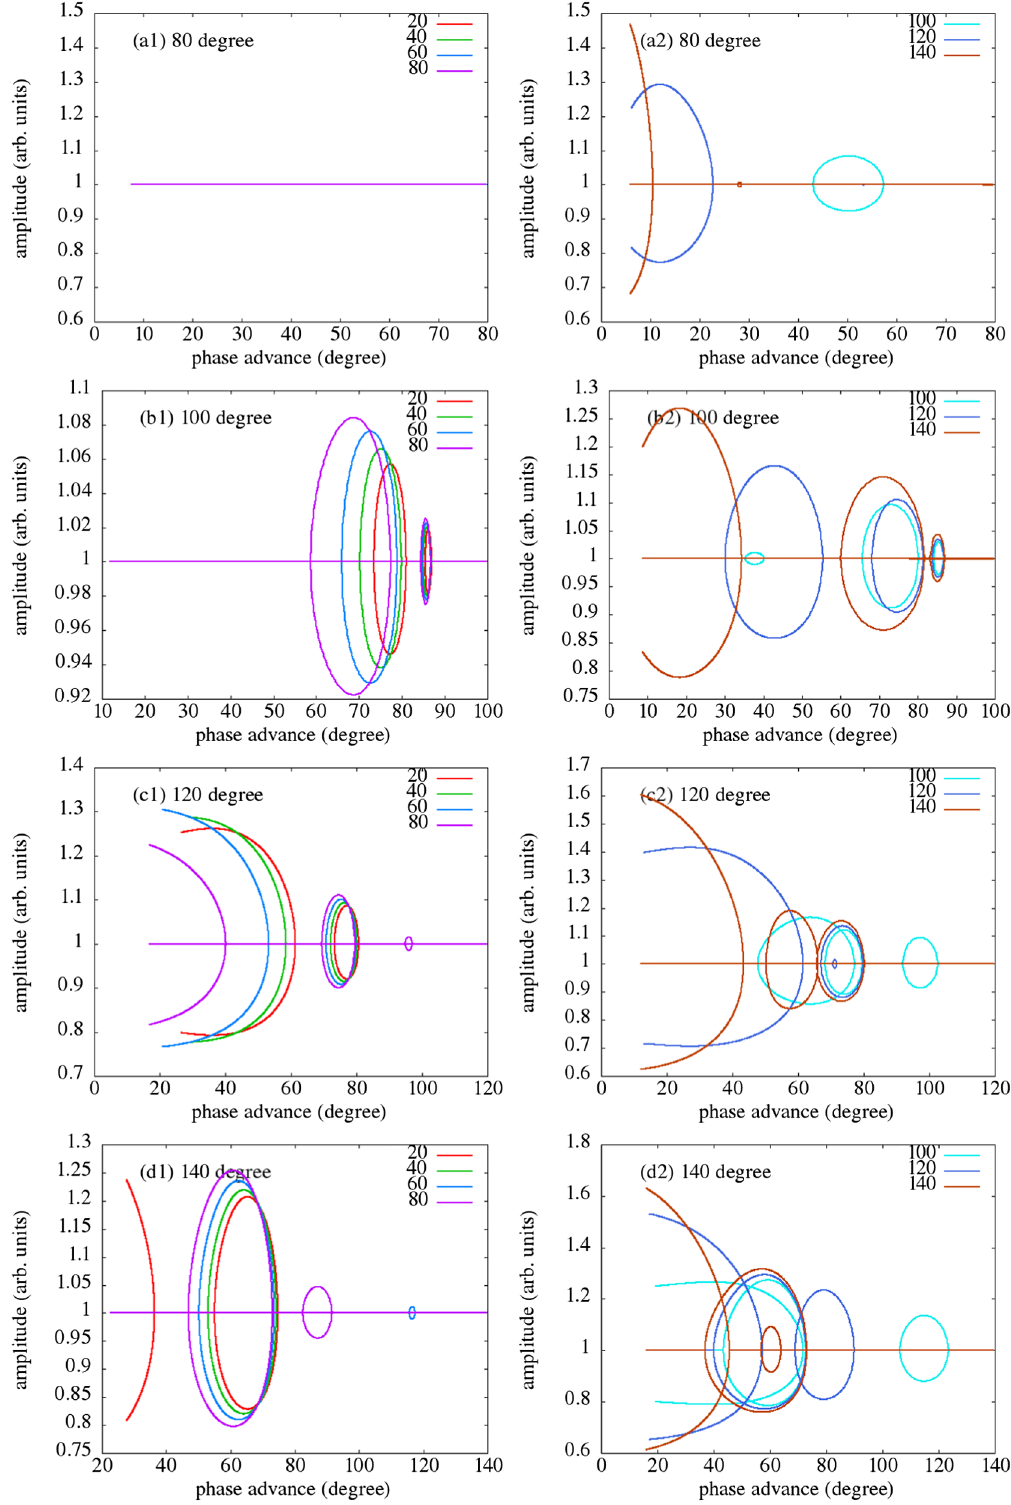
FIG. 2. The 3D envelope mode growth rate amplitudes as a function of depressed transverse phase advance with 20 °, 40 °, 60 °, 80 °, 100 °, 120 °, and 140 ° zero current longitudinal phase advances for (a) 80 °, (b) 100 °, (c) 120 °, and (d) 140 ° zero current transverse phase advances in a periodic solenoid-rf